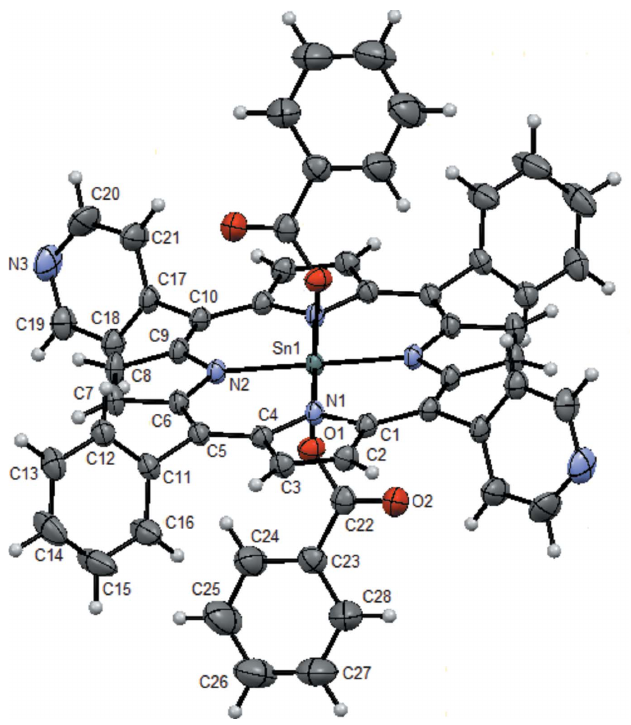
Figure 1 The molecular structure of the title compound with displacement ellipsoids drawn at the 50% probability level. Unlabelled atoms are generated by the symmetry operation (cid:5) x + 1, (cid:5) y + 1, (cid:5) z + 1.